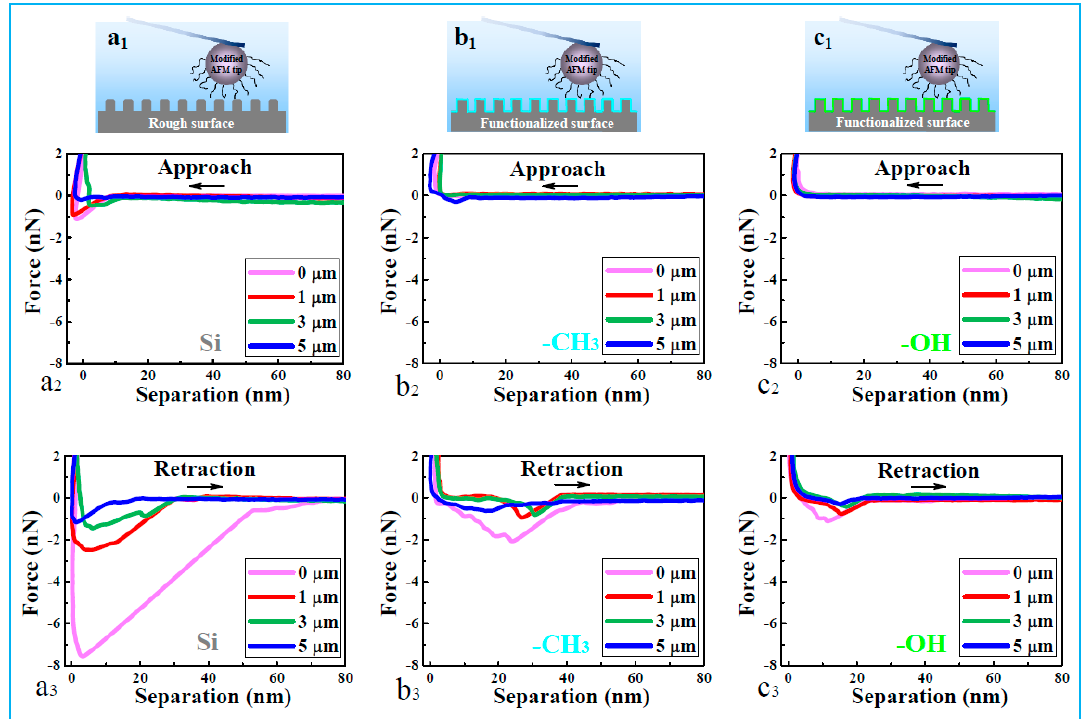
Figure 2. Schematic representation of approach and retraction force curves as a function of separation between 3,4-dihydroxyphenylalanine (DOPA) (modified AFM tip) and functionalized surfaces in buffer solution at different feature heights. (Bare Si surfaces: a 1 , a 2 , and a 3 ; CH 3 -terminated surfaces: b 1 , b 2 , and b 3 ; OH-terminated surfaces: c 1 , c 2 , and c 3 ).